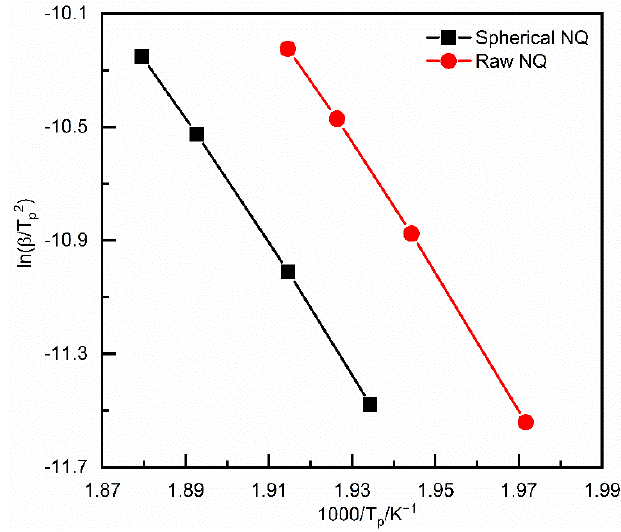
Figure 4. Kissinger plots for the exothermal peaks of the DSC curves of NQ. Table 3. Thermal reaction kinetic parameters for the materials.